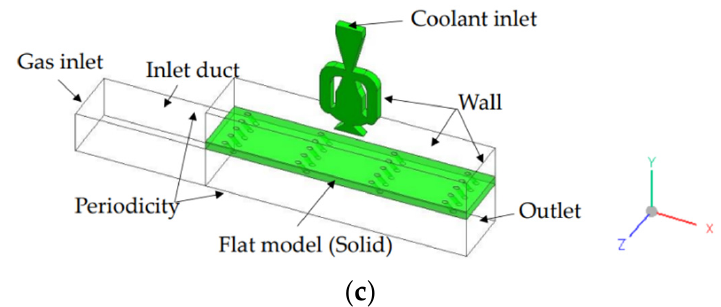
Figure 1. Schematic of the model and boundary condition. ( a ) The Fluidic Oscillator [14], ( b ) The novel direct jet, ( c ) Computational domain and boundary conditions.